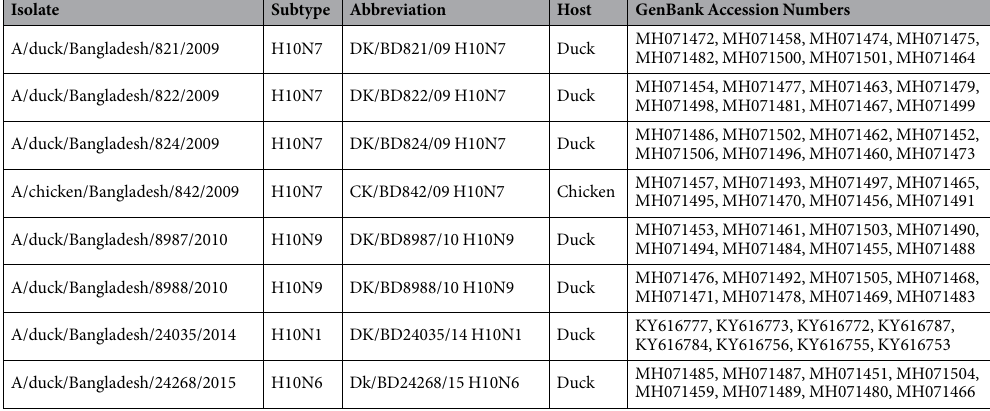
Table 1. H10 AIVs isolated from LPMs in